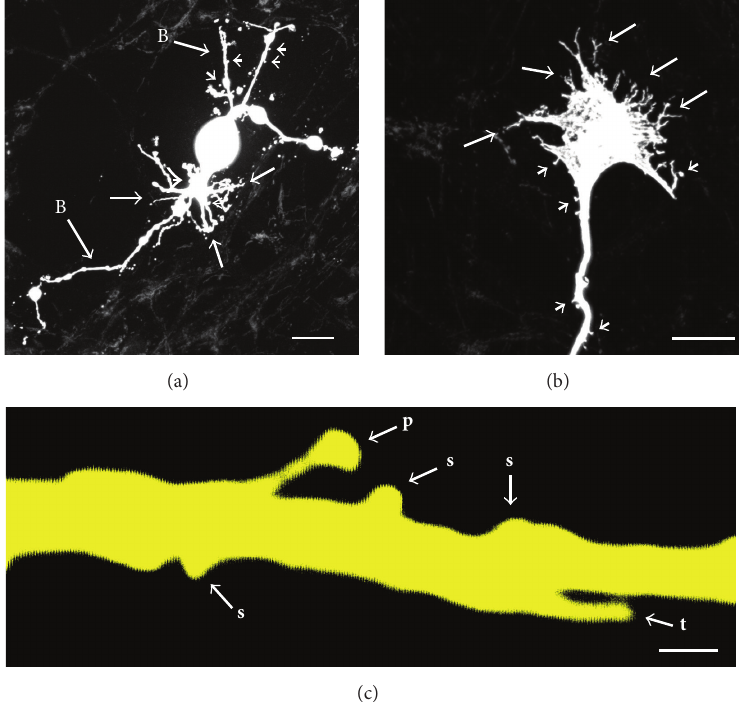
Figure1:(aandb)showformationoffilopodiaandspine-likeprocesses(protospines)onneuritisanddendriticgrowthconesfromdeveloping (immature) human cortical neuron-like cells derived from induced pluripotent stem (iPS) cells in culture without synaptic inputs. These cells were dye-filled from their soma with a less invasive semiloose seal Neurobiotin electroporation method, and Neurobiotin was visualized by incubating cells in Streptavidin Cy3 (for methods see Kanjhan and Vaney, 2008 [25]). (a) shows the formation of neurite branches (“B-arrows”), filopodia (long arrows), and spine-like processes or protospines (short arrows) protruding from the soma and neurites in a developing immature neuron-like cell. (b) shows a high-magnification image of a dendritic growth cone with filopodia (thin long processes) and spine-like processes (shorter protrusions; short arrows) protruding from its circumference, in the absence of any synaptic inputs. The same cell had a much longer axonal growth cone extending from soma in opposite direction (not shown). (c) shows the types of spines found in the dendrites of a hypoglossal motoneuron from a 15-postnatal-day-old wild-type C57/Bl6 mouse. In this panel, all types of spines previously reported in other neuronal types are evident. These include (p) pedunculated spines that are thin and longer with prominent necks and heads resembling mushrooms; (s) sessile spines that show stubby or short lacking clear necks; (t) thin spines that are longer filopodia-like spines and lack clear necks and mushroom-like heads. All images were taken with a 100x oil objective (NA 1.35) using 2.5x (b) and 10x (c) optical zoom using an Olympus BX61 (Olympus Fluoview ver. 1.7c) microscope. Each micrograph is a confocal image stack of 10 × 0.35 𝜇 m (a and b) and 3 × 0.35 𝜇 m (c) thick optical sections. Scale bar = 10 𝜇 m in (a-b) and 1 𝜇 m in